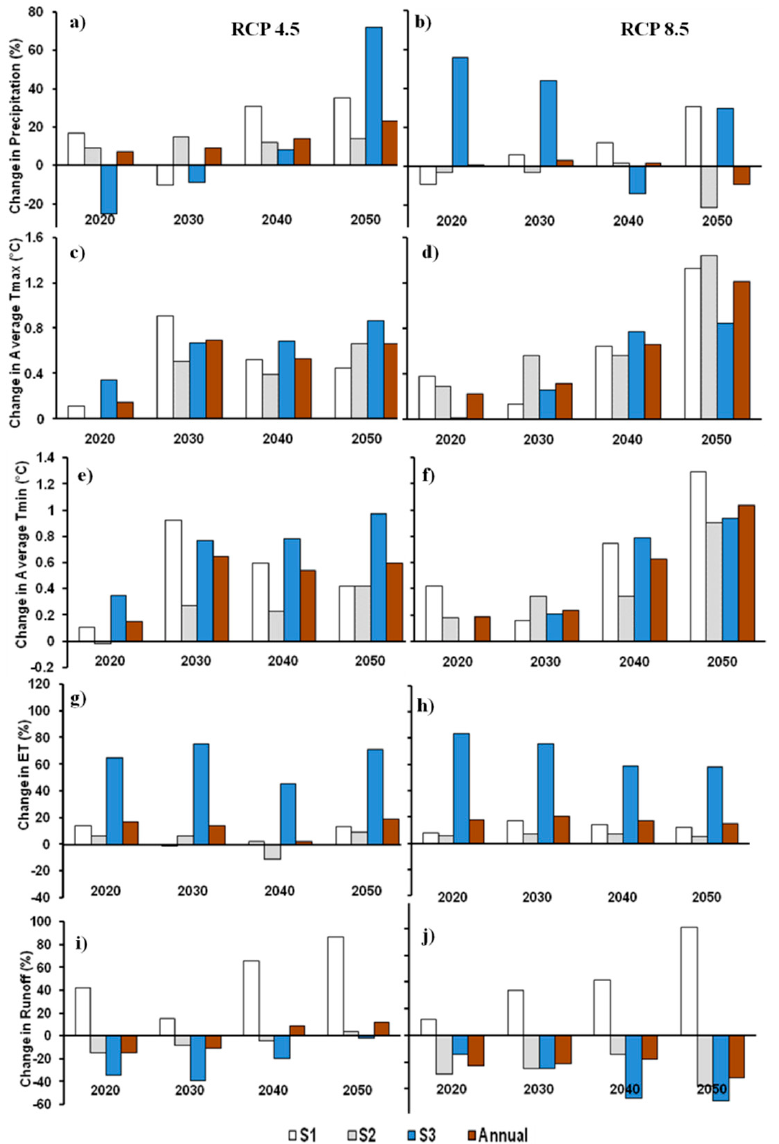
Figure 6. ( a ) Percentage change in precipitation for representative concentration pathway (RCP)4.5, ( b ) Percentage change in precipitation for RCP8.5, ( c ) Change in average T max for RCP4.5, ( d ) Change in average T max for RCP8.5, ( e ) Change in average T min for RCP4.5, ( f ) Change in average T min for RCP8.5, ( g ) Percentage change in evapotranspiration(ET) for RCP4.5, ( h ) Percentage change in evapotranspiration (ET) for RCP8.5, ( i ) Percentage change in runoff for RCP4.5, ( j ) Percentage change in runoff for RCP8.5 with respect to baseline data (2010) for climate and land use/cover. Table 7. Percentage change in river runoff due to projected changes in climate only, land use/cover (LULC) only, and combination of both changes in Kathmandu Valley watershed. 1.